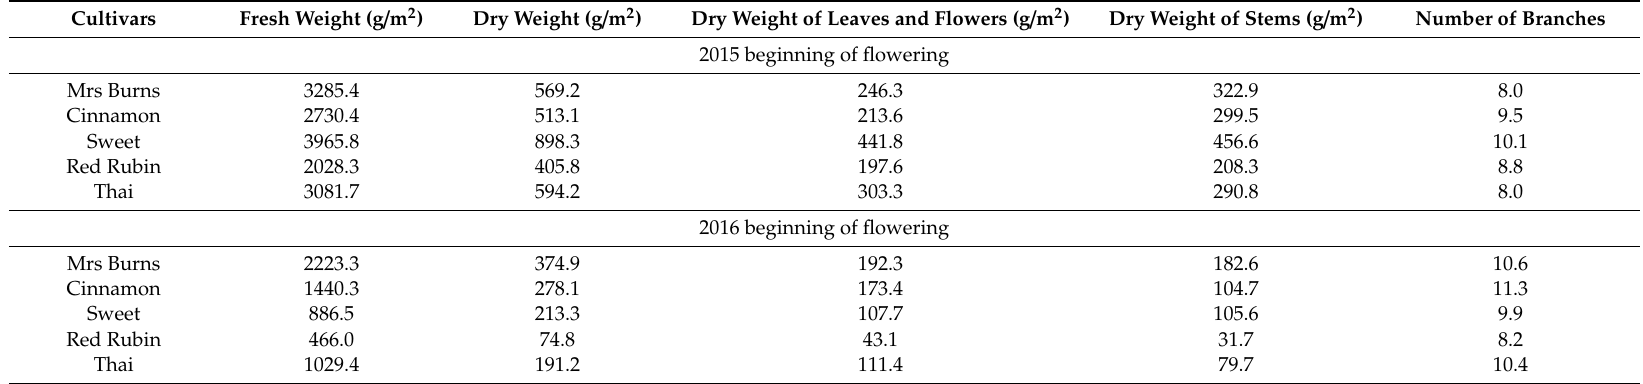
Table 4. Combined e ff ect of Cultivar, Year (2015, 2016), and Growth Stages, and the main e ff ect of Irrigation on fresh and dry weight, dry weight of leaves, flowers, and stems, and number of branches. Data presented are mean values, where LSD is the least significant di ff erence at the 0.05 significance level. Cultivars Fresh Weight (g / m 2 ) Dry Weight (g / m 2 ) Dry Weight of Leaves and Flowers (g / m 2 ) Dry Weight of Stems (g / m 2 ) Number of Branches 2015 beginning of flowering 3285.4